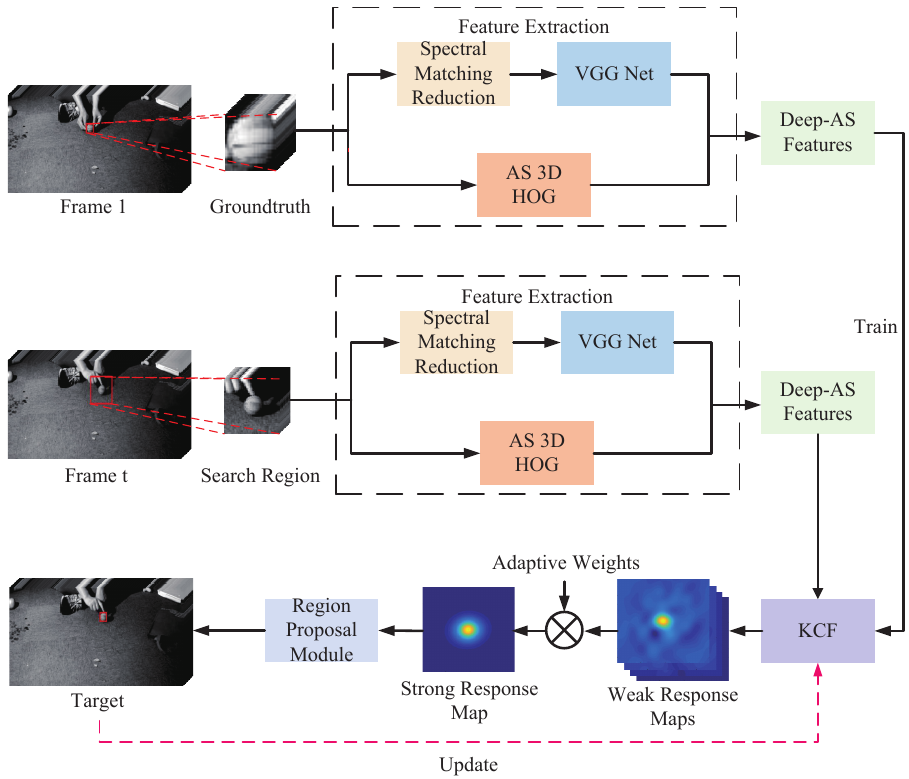
Figure 1. The overall framework of our